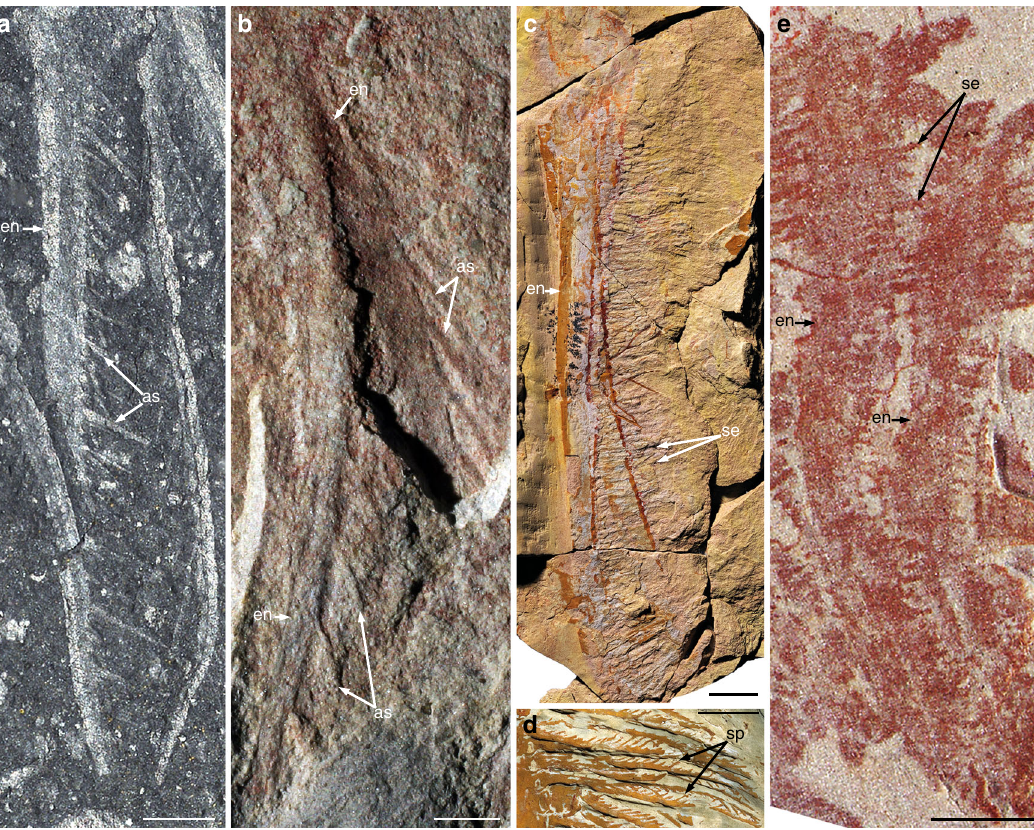
Fig. 3 Endite morphologies in suspension-feeding radiodonts. Photographs of specimens immersed in dilute ethanol ( a ) or dry ( b – e ). a , b Endites with numerous auxiliary spines. a Early Cambrian Tamisiocaris borealis (MGUH30501; image: J. Vinther). b Early Cambrian Anomalocaris briggsi (SAM P47020a; image: J. Paterson). c , d Endite with numerous complex setae, Early Ordovician Aegirocassis benmoulae (images: P. Van Roy). c General view (YPM522227). d Detail of the setae and their spinules (YPM527125). e Endite with numerous simple setae, middle Cambrian Pahvantia hastata (KUMIP314089). Scale bars represent 1 cm ( c , d ) and 2 mm ( a , b , e ). as auxiliary spines, en endites, se setae, sp